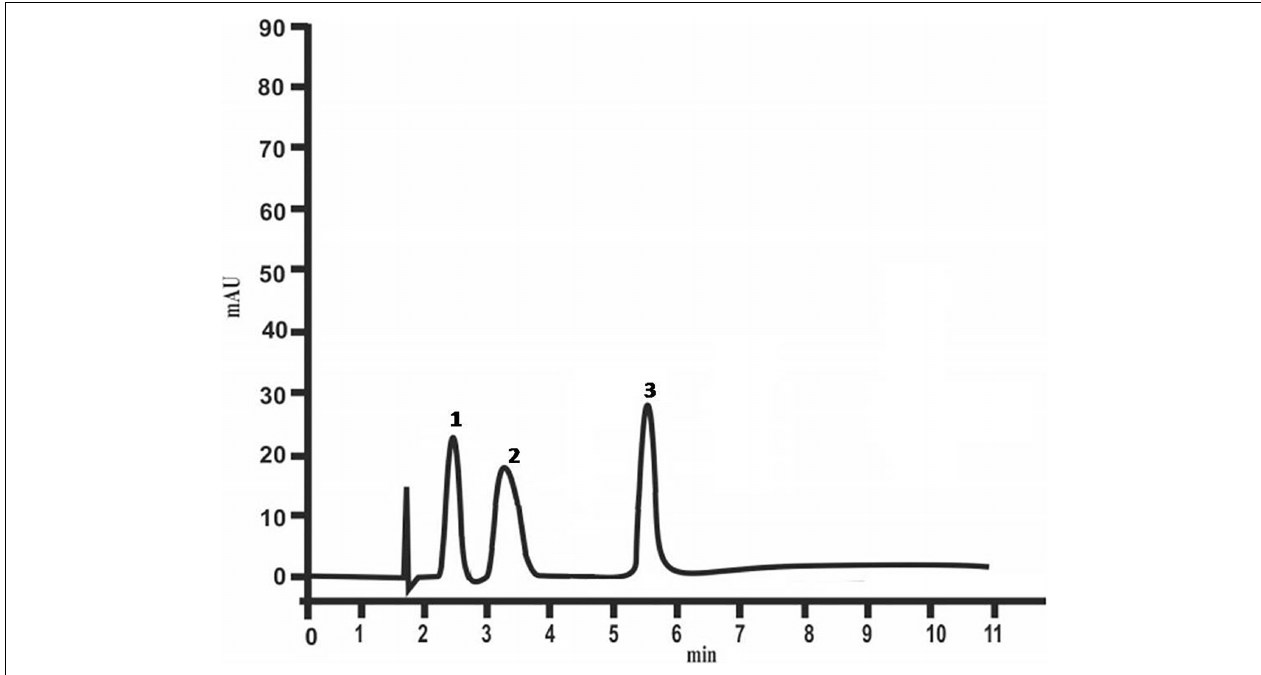
FIGURE 4 | Chemical composition of colloidal polysaccharides of At. ferrooxidans Ksh (1 – glucose, 2 – fructose, 3 – xylose) analyzed by HPLC.